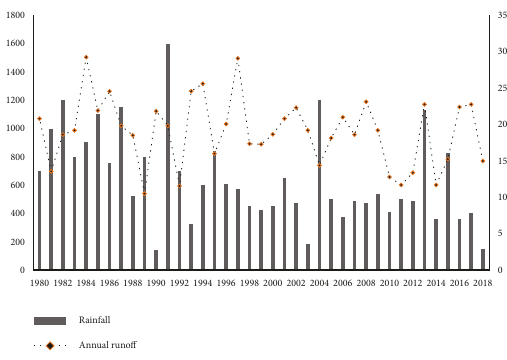
Figure 2: The annual runoff simulation results.